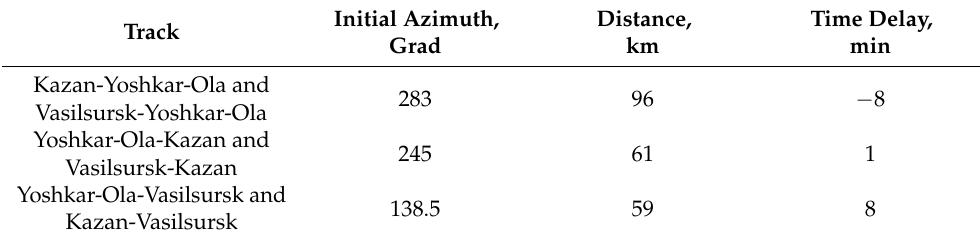
Table 3. Time delay of